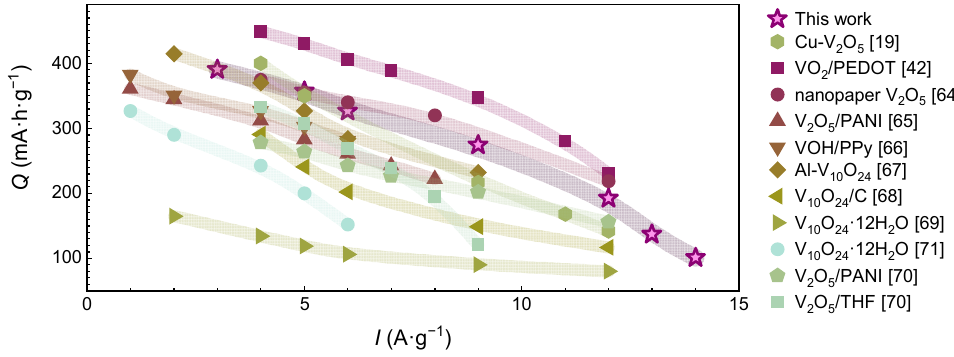
Figure 6. The comparison of the VO@PEDOT cathode with other V 2 O 5 -based cathodes for Zn-ion batteries [19,42,63–71].